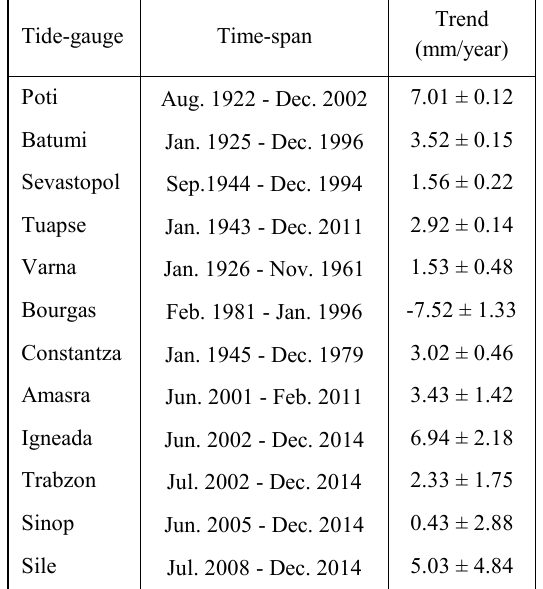
Table 2. Trends of relative sea level changes at the tide-gauge stations along the Black Sea coast (The longest data periods of the tide-gauges were used for the analysis).